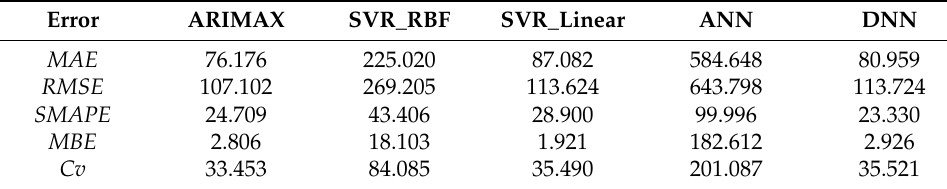
Table 13. The results of the single-site solar PV generation model using the multisite data set. Error ARIMAX SVR_RBF SVR_Linear ANN DNN MAE 76.176 225.020 87.082 584.648 80.959 RMSE 107.102 269.205 113.624 643.798 113.724 SMAPE 24.709 43.406 28.900 99.996 23.330 MBE 2.806 18.103 1.921 182.612 2.926 Cv 33.453 84.085 35.490 201.087 35.521